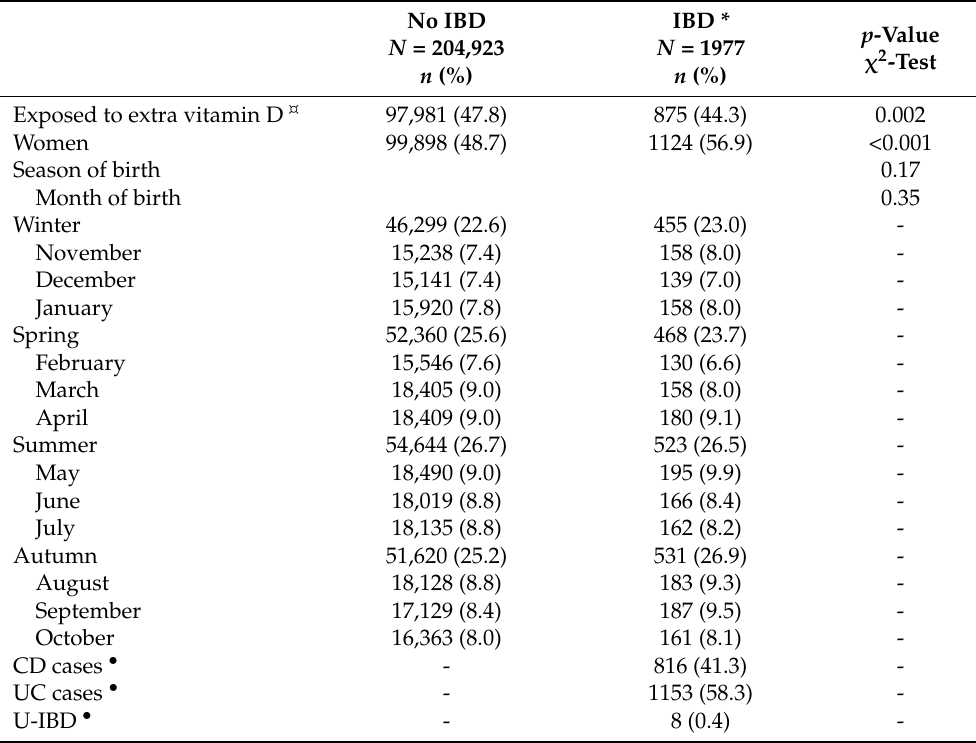
Table 1. Characteristics of the study population at follow-up (age 30 years), according to the diagnosis of incident IBD.